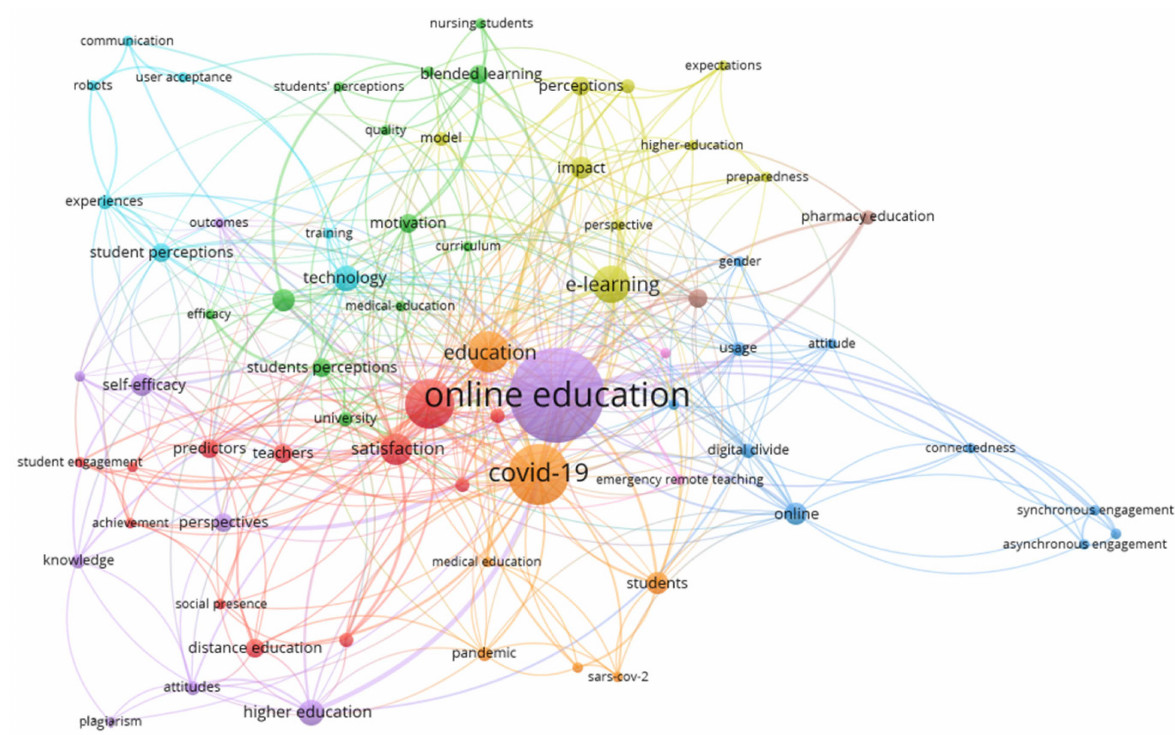
Figure 6. VOSviewer mapping of student perceptions of online education with respect to co- occurrence. Source: authors’ own analysis with